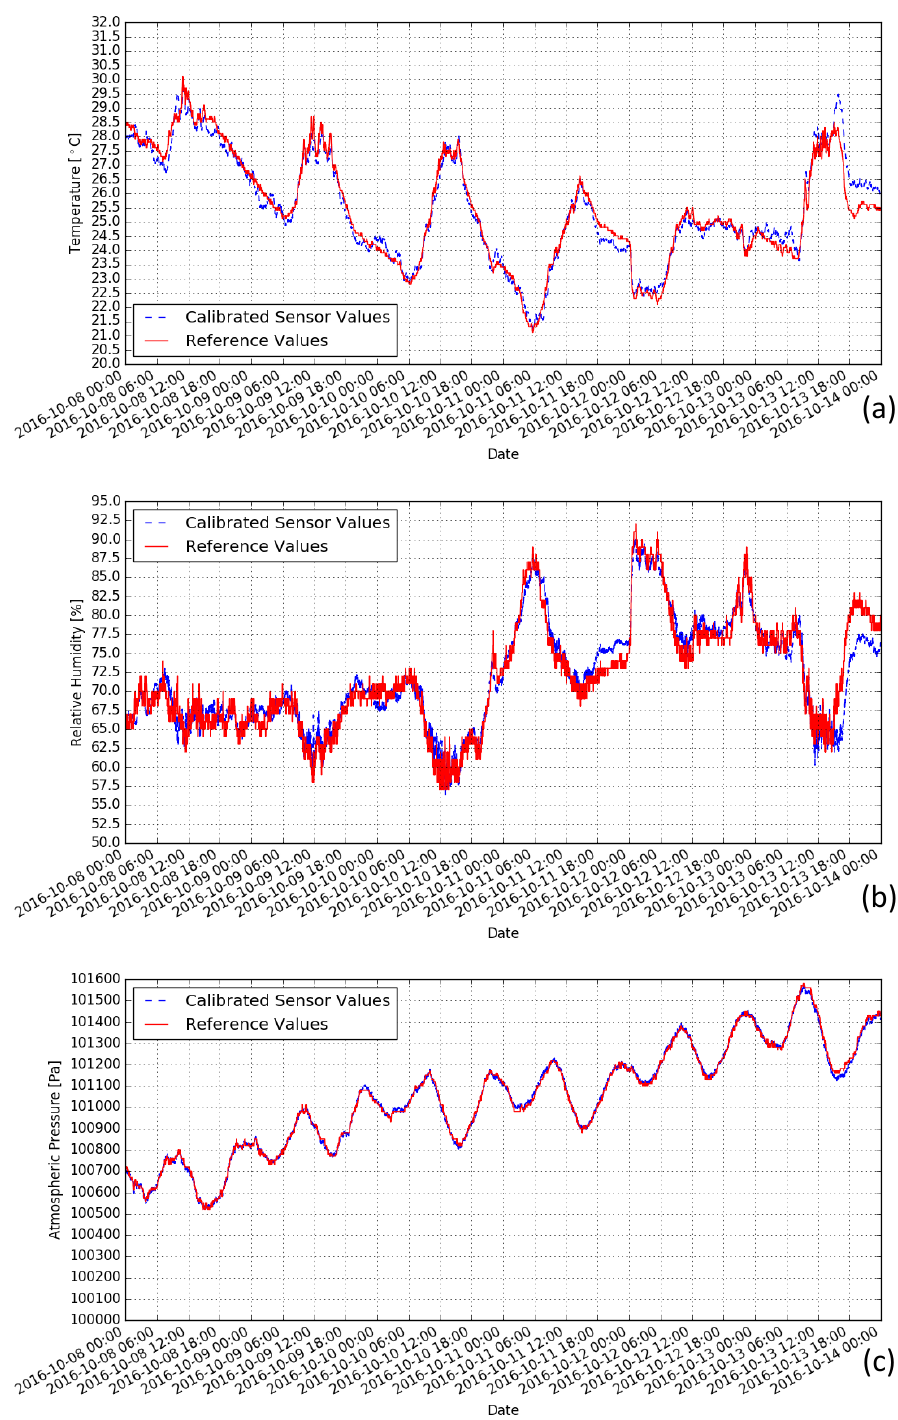
Figure A2. Line plots of calibrated sensor values from THP Sensor-Module and reference values from HKO’s station. ( a ) temperature data pairs; ( b ) relative humidity data pairs; ( c ) atmospheric pressure data